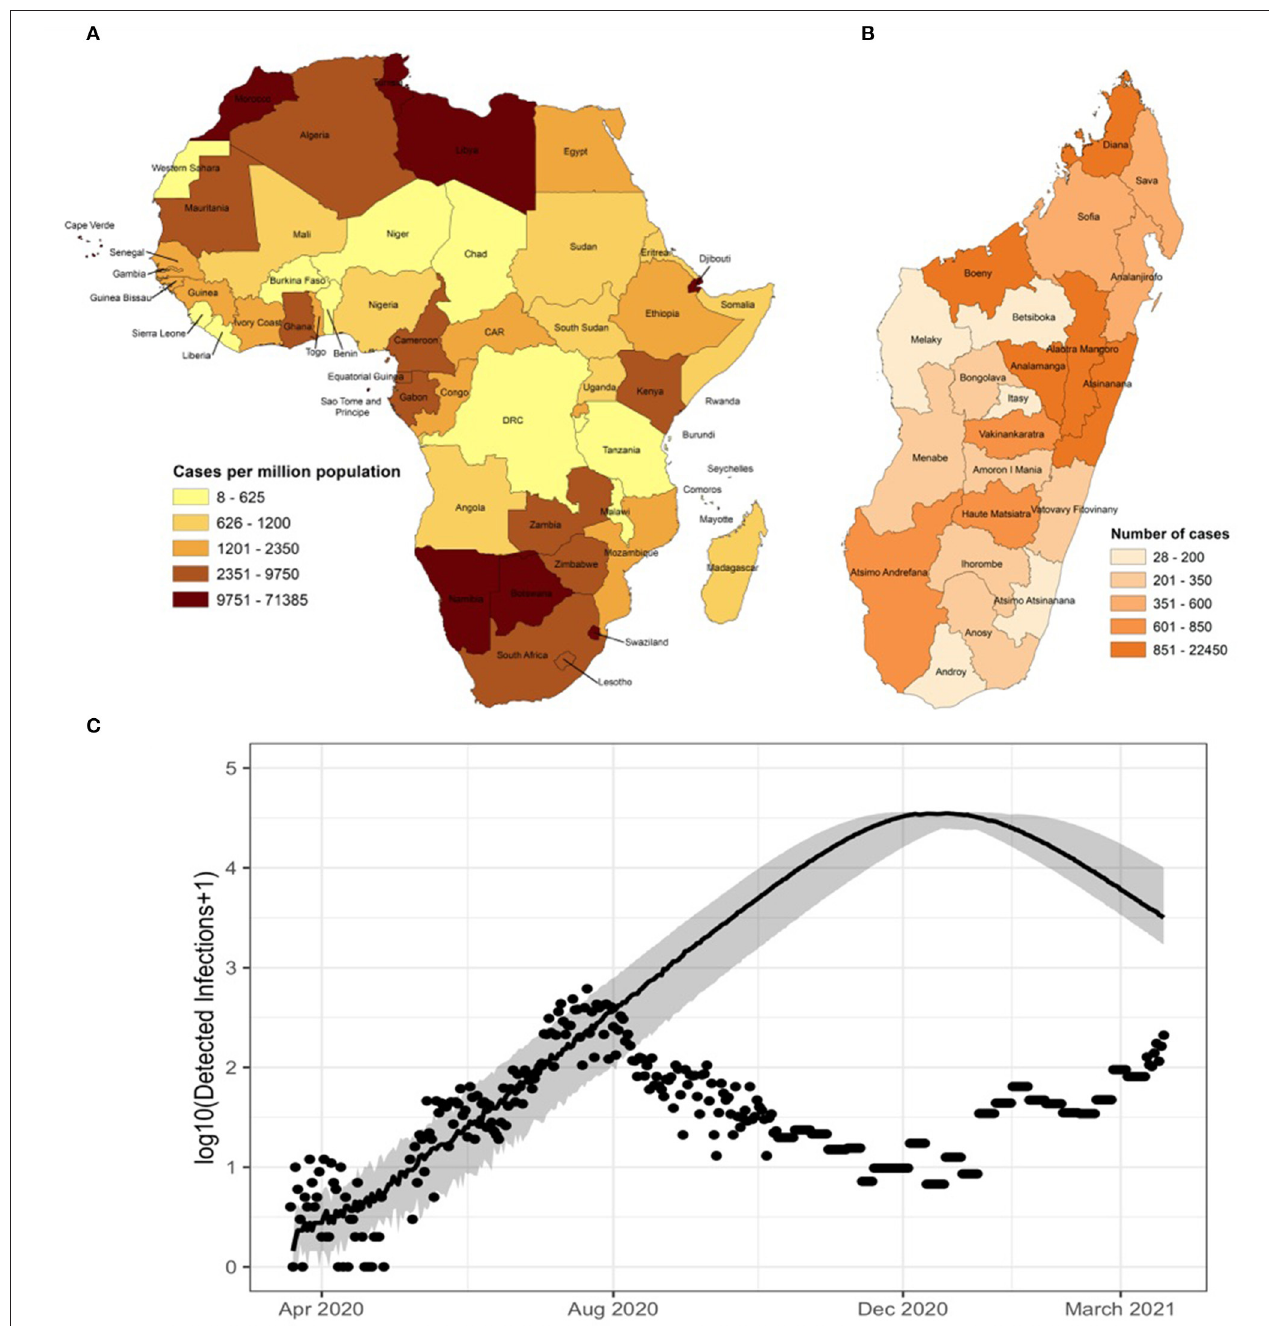
FIGURE 1 | (A) Cumulative total cases per million population for each country in the African continent as of April 21 2021 (1). (B) Cumulative total cases per region in Madagascar through April 21 2021 (1). (C) Updated estimate of COVID-19 dynamics (solid line) based on reported data and mathematical model for Madagascar shows that even conservative models predicted disease prevalence that is orders of magnitude greater than public case reports (dots) to date [for details on this model, see (3)].